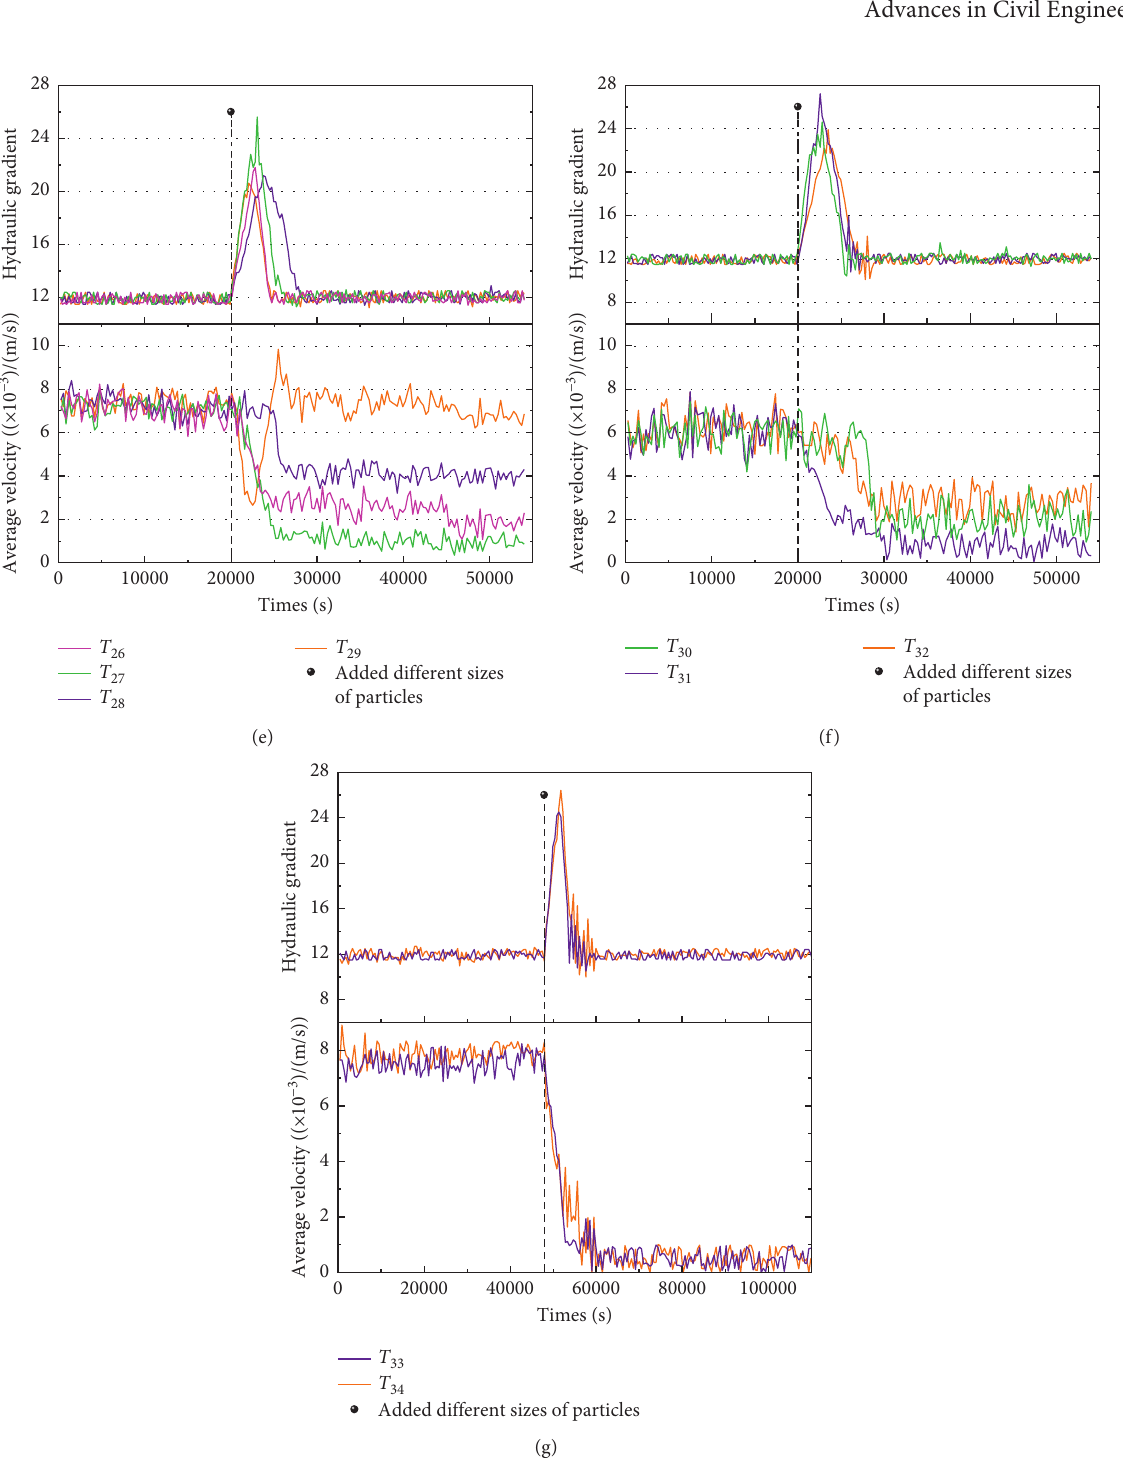
Figure 3: Evolution of the hydraulic gradient and the flow velocity in six groups of soil media samples. (a) Soil media PS of 32–64mm. (b) Soil media PS of 16–32mm. (c) Soil media PS of 8–16mm. (d) Soil media PS of 4–8mm. (e) Soil media PS of 2–4 mm. (f) Soil media PS pf 1–2mm. (g) Soil media PS of